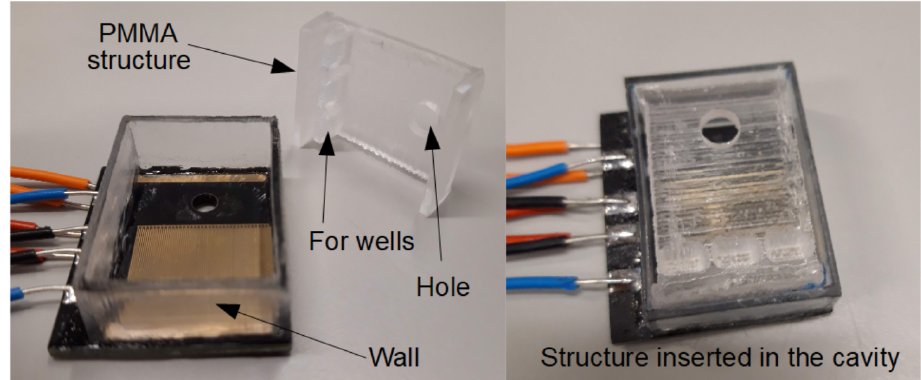
Figure 2. The lab-on-PCB with the thermoplastic wall and the auxiliary structure are shown. In order to clarify the assembly, a drawing of a cross-sectional view of the lab-on-PCB is shown in Figure 3. As can be seen, the transparent film is placed on the top side of the PCB substrate, and the LDR sensor is located below the transparent film. The detection system is not included because it is an independent part of the system.